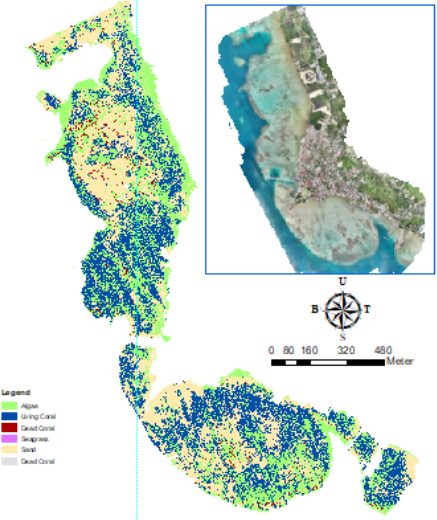
Fig. 10. Classification using SVM algorithm with a scale parameter of